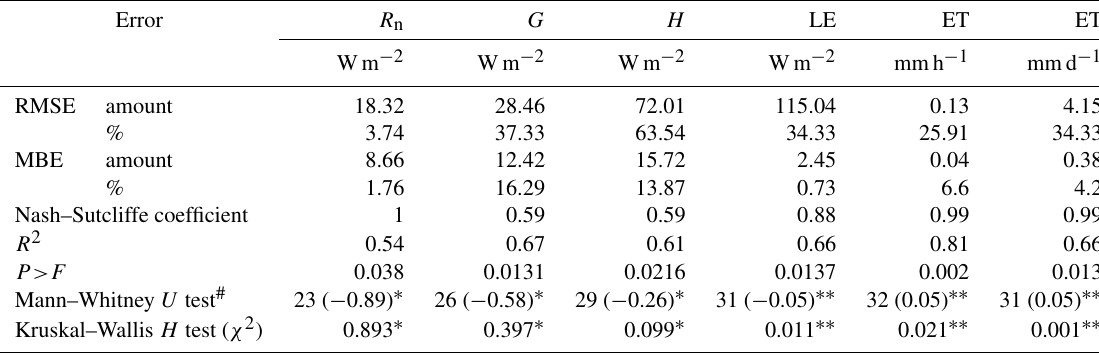
Table 8. Performance indicators results for the METRIC algorithm estimated EB